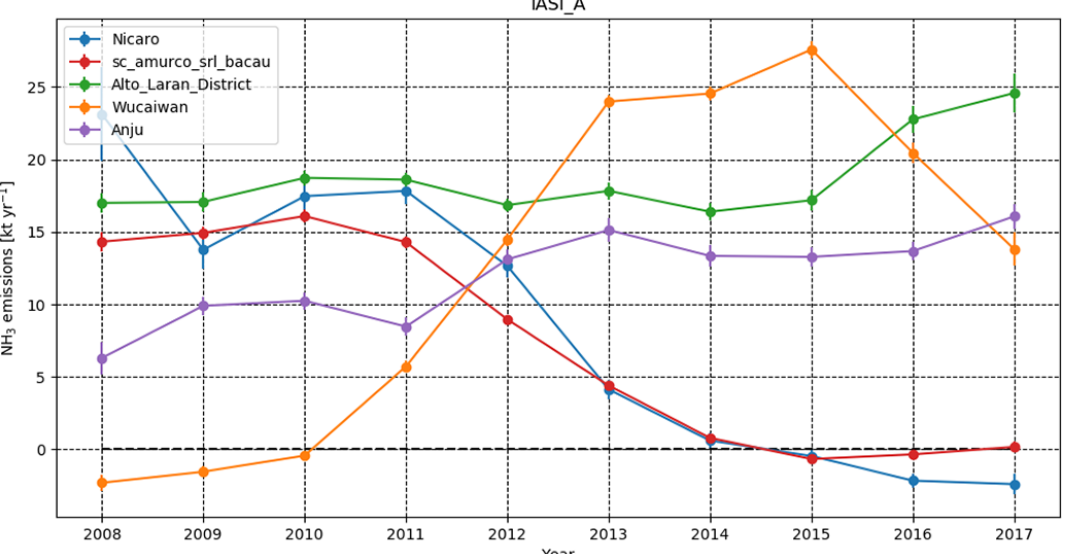
Figure E2. Example of IASI-A (2008–2017) 3-year running mean emissions for locations mentioned in Van Damme et al. (2018) using the method used in this